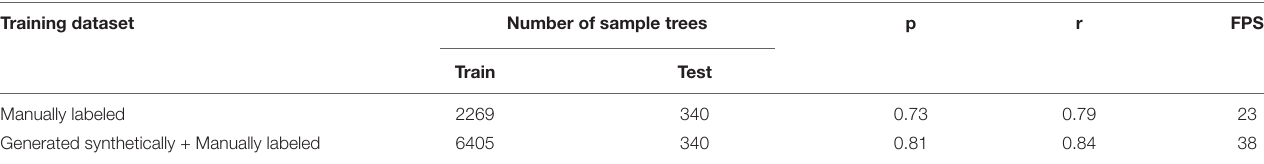
TABLE 3 | Comparison results between the detection accuracy of YOLO trained on a manually labeled dataset and that of YOLO trained on an augmented GAN-generated synthetic dataset on the same testing samples (all trained on the overall training samples of the three study